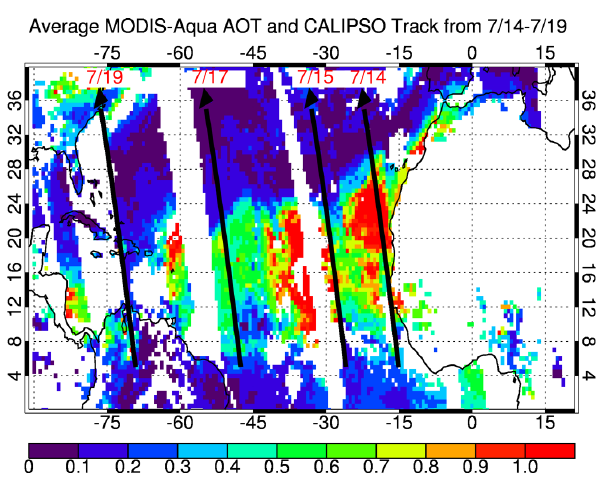
Fig. 4. Average MODIS-Aqua AOT and CALIPSO track from 14– 19